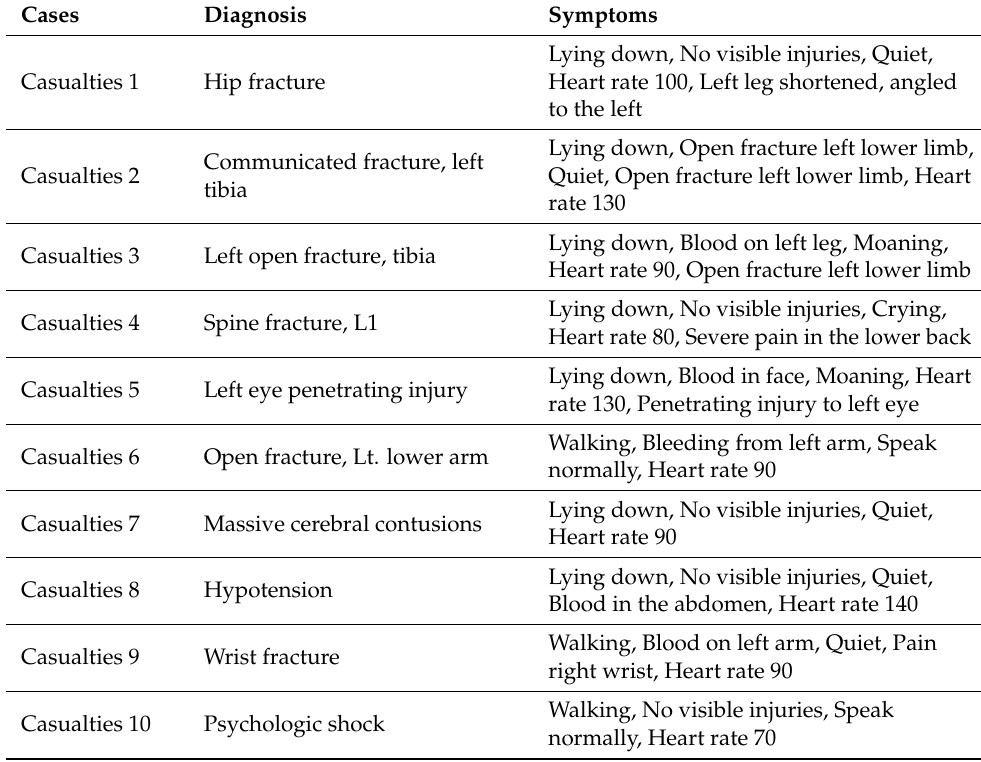
Table 1. The cases of virtual